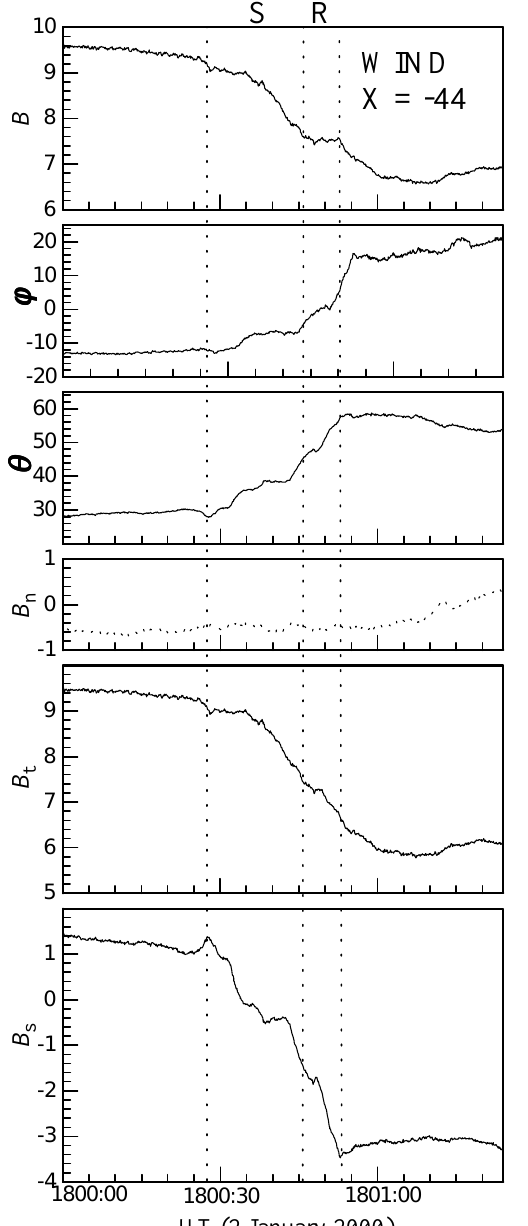
Fig. 11. A double discontinuity observed from Wind on 3 January 2000. The observed structure is composed of a slow shock layer (S- layer) and an adjoining rotational layer (R-layer) on the postshock